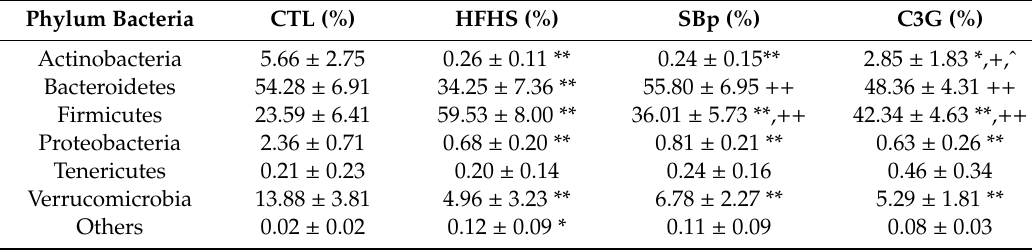
Figure 5. E ff ect of the HFHS diet supplemented with C3G on β -diversity of gut microbiota in mice. The experimental regimen was described in the legend of Figure 1. Principle component analysis (PCA) was based on Bray–Curtis dissimilarities between all sample sets (weighted by taxon abundance). Table 1. E ff ect of di ff erent diets on the abundances of gut microbiota on phylum